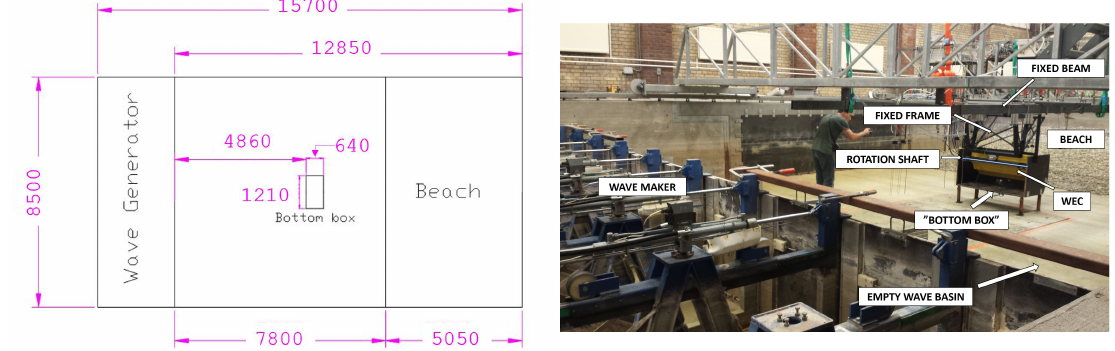
Figure 5. Left : Bird’s eye view of position of bottom box in wave basin set up for heading waves (measurements in mm). Right : Photo of the setup in the basin with the beach in the background.